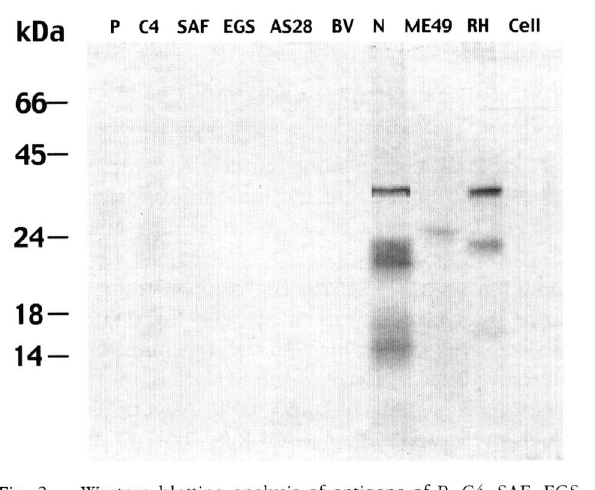
Fig. 2 - Western blotting analysis of antigens of P, C4, SAF, EGS, AS28, BV, N, ME49 and RH strains of Toxoplasma gondii reacted with mAb 4C3H4. Equal numbers (10 4 ) of purified tachyzoites from each strain were subjected to 12,5 % polyacrylamide gel and elec­ trophoretically transferred to nitrocellulose membrane. Molecular weight markers (in kilodaltons) are indicated on the left. Cell - cells obtained from peritoneal cavities of Swiss mice not infected with T. gondii.